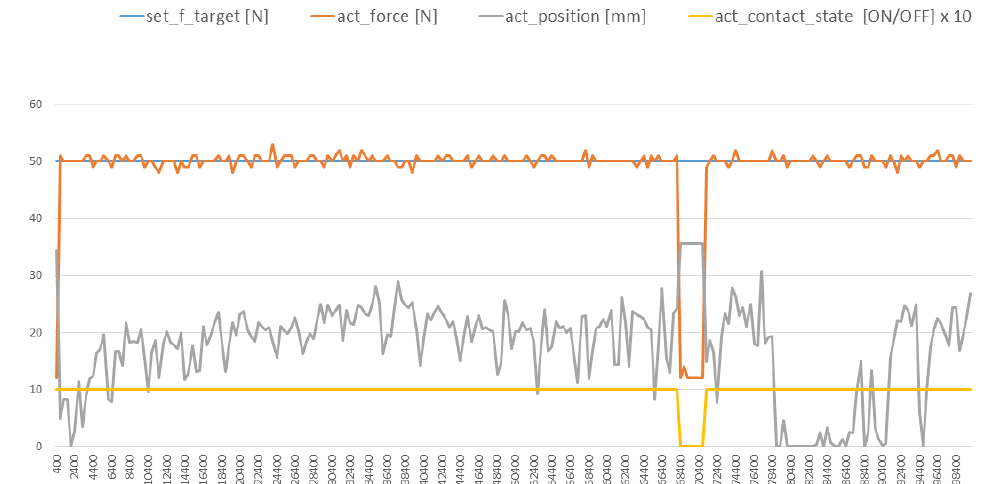
Figure 14. Graph showing the progress of the robotic end-effector during a reconditioning grinding operation. The curves show the target force (orange), actual force (blue) during grinding; actual height of the end-effector (grey) and whether there was contact or not contact with surface (yellow). The yellow curve is actually binary (1 or 0) but we have multiplied it by a factor of 10 to show it clearly.